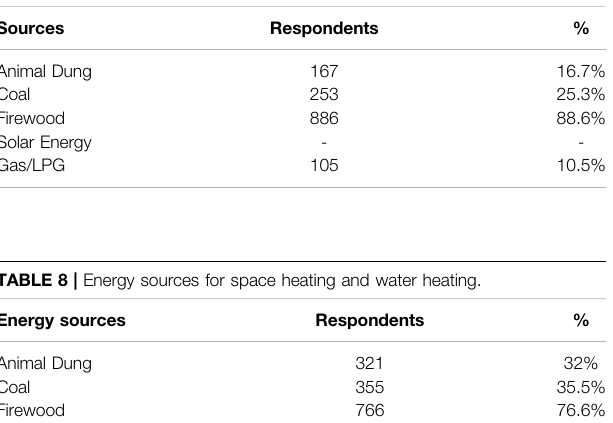
TABLE 7 | Energy sources for cooking.